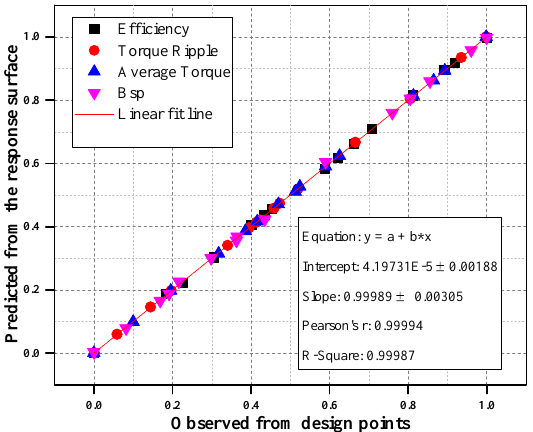
Figure 10. Fit accuracy plot showing how closely the output parameters fit the expected response.